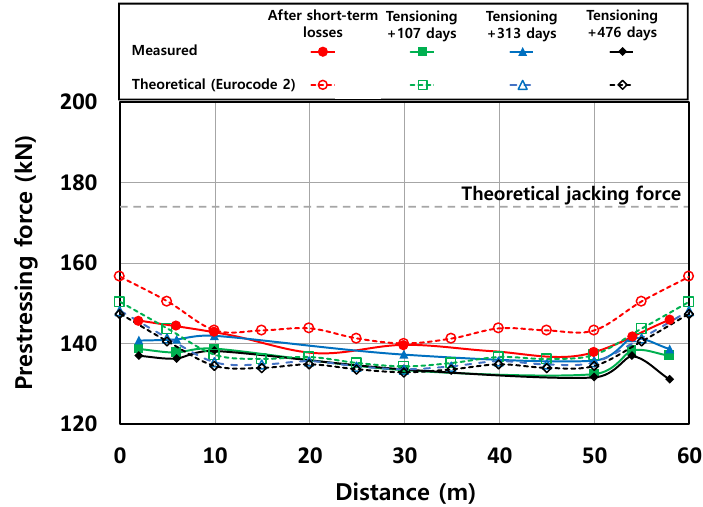
Figure 9. Distribution of PFs in the PSC girder bridge.